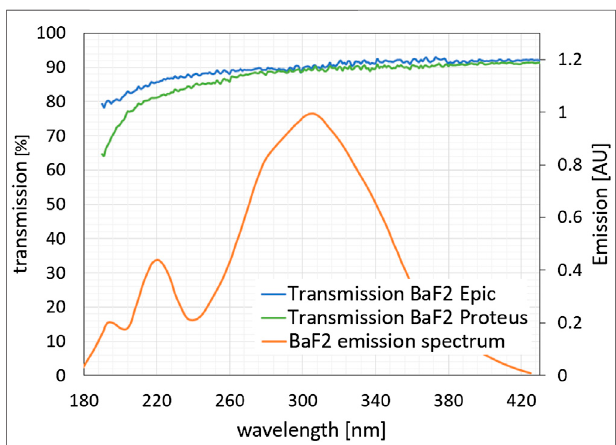
FIGURE 4 | Transmission measurements with BaF 2 produced by Epic and by Proteus, together with its emission spectrum from literature [22].